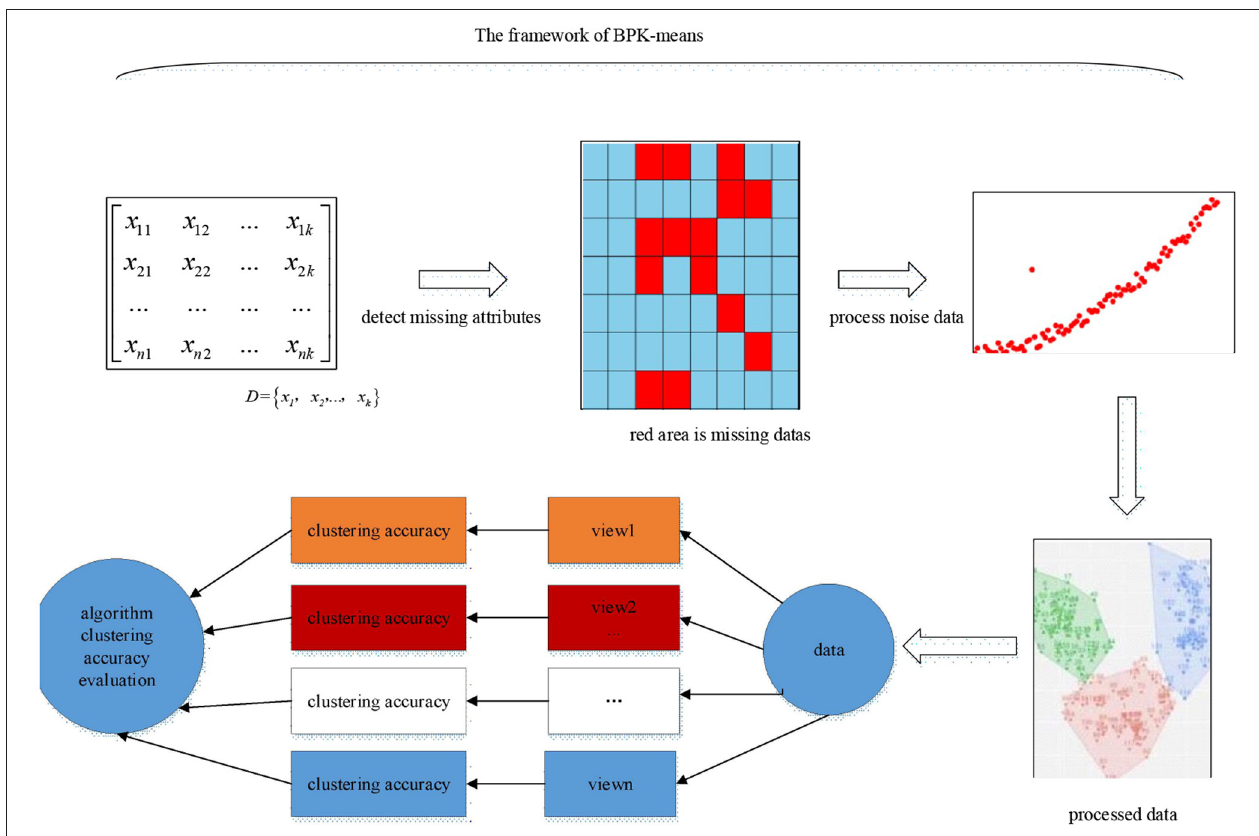
FIGURE 3 | Flow Diagram of BPK-means